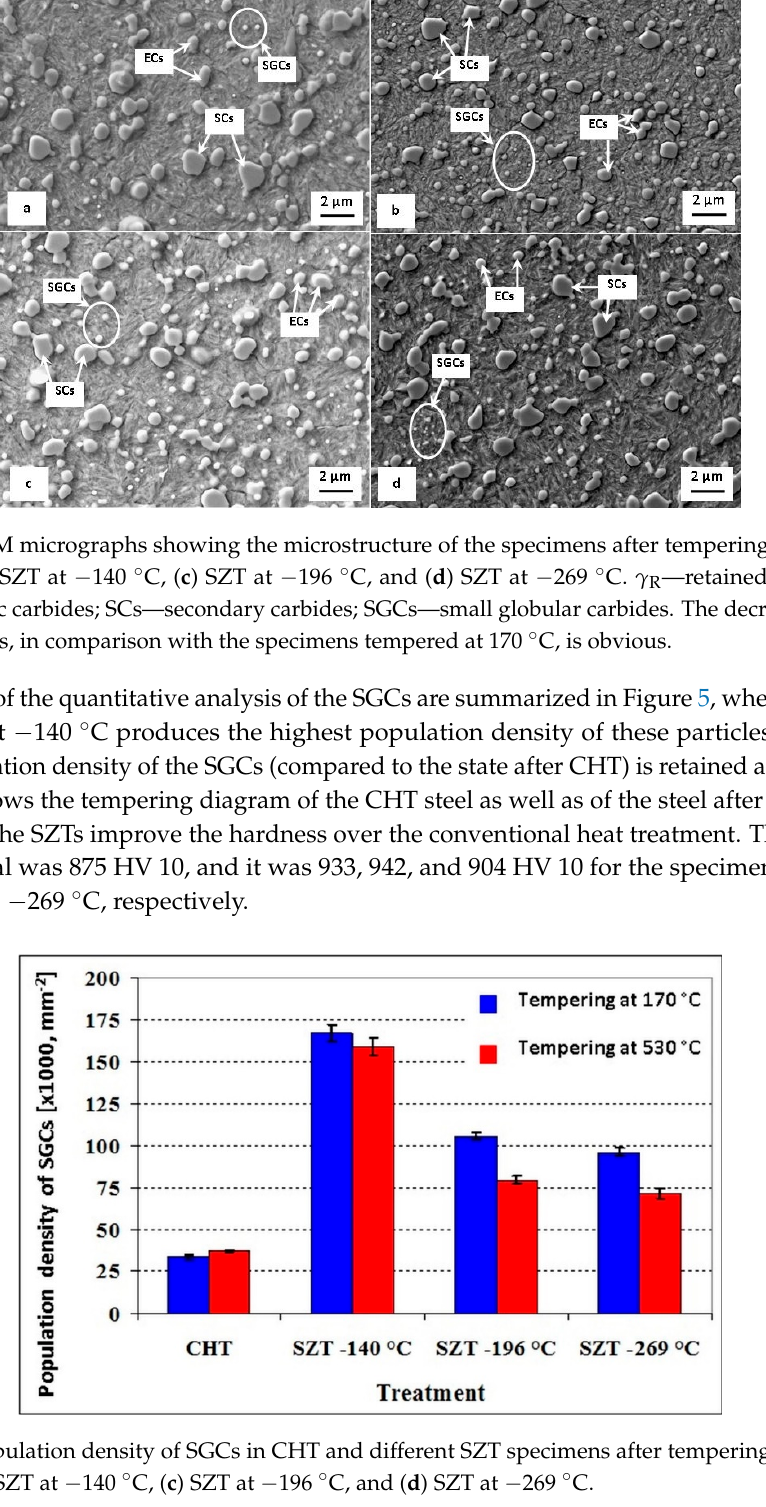
Figure 3. Typical SEM micrographs showing the microstructure of specimens after tempering at 170 °C: ( a ) CHT, ( b ) SZT at − 140 °C, ( c ) SZT at − 196 °C, and ( d ) SZT at − 269 °C. γ R —retained austenite;